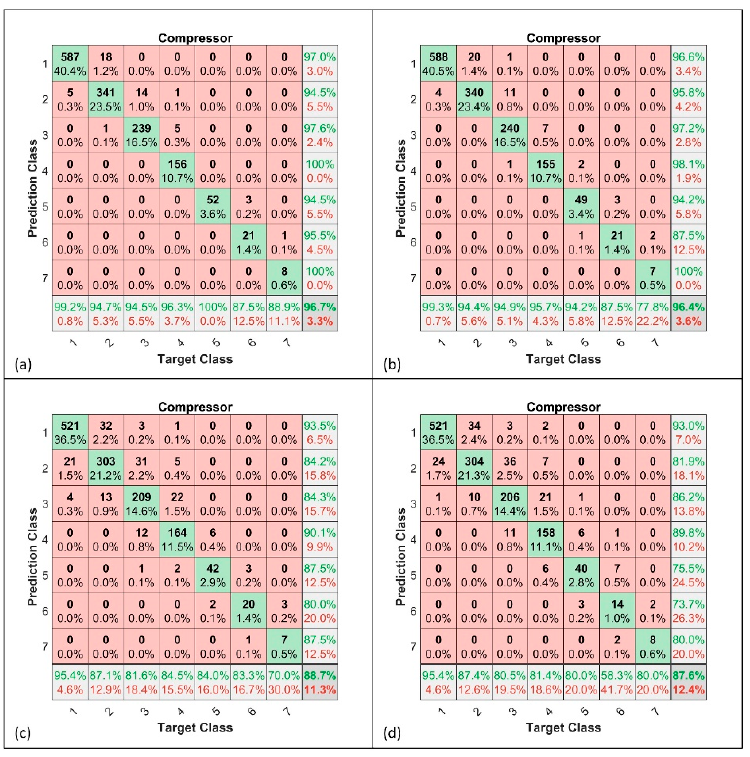
Figure 11. Confusion matrix for compressor. ( a ): Single-component FFNN; ( b ): single-component KPCA + FFNN; ( c ): multi-component FFNN; ( d ): multi-component KPCA + FFNN.